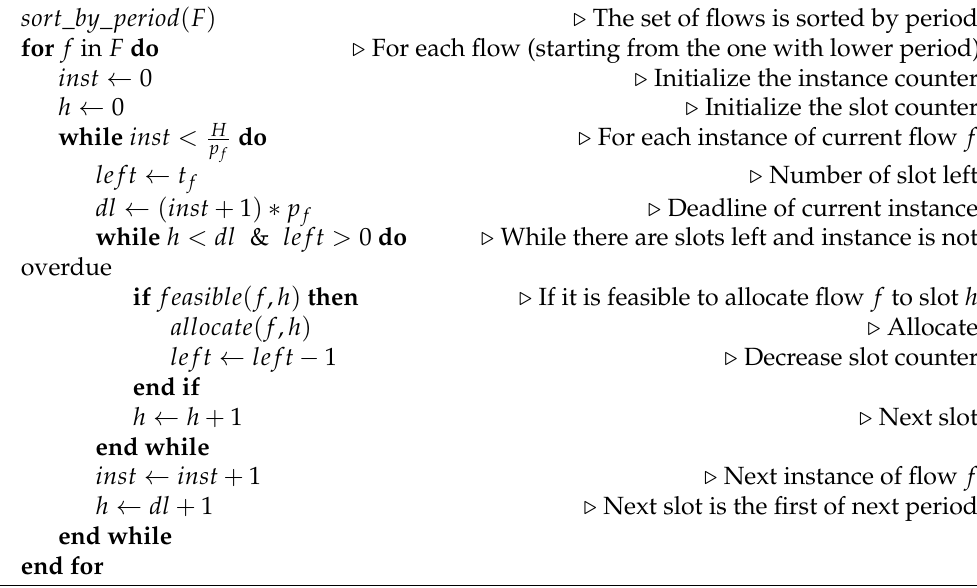
Algorithm 2 First phase scheduling algorithm: second approach.